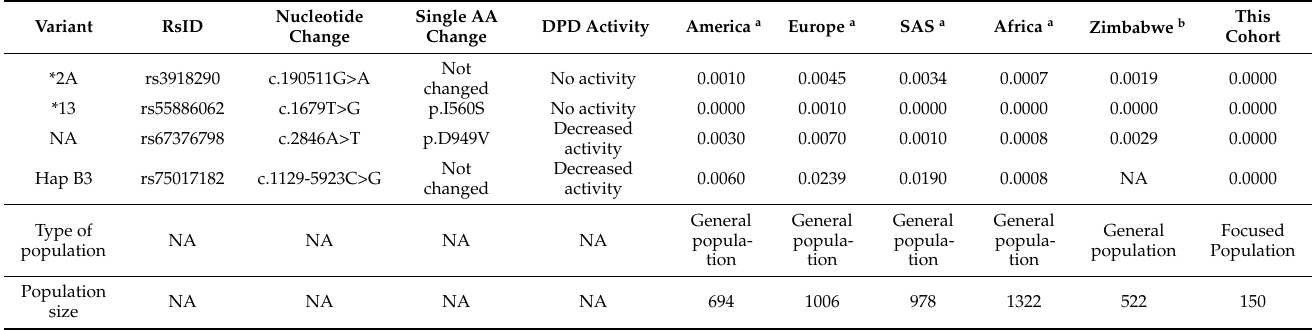
Table 2. The frequency of CPIC DPYD pathogenic variants in different